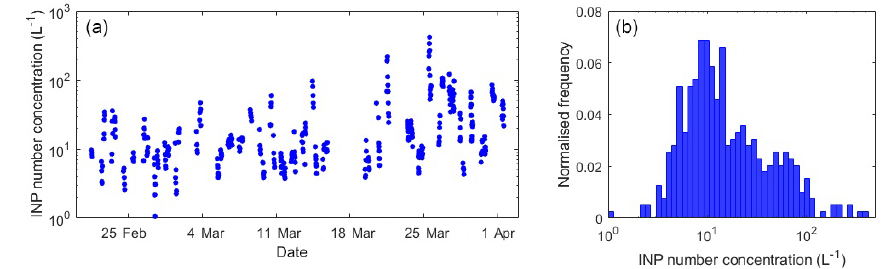
Figure 2. The [INP] time series throughout the whole campaign (a) and its normalised frequency distribution (b) .